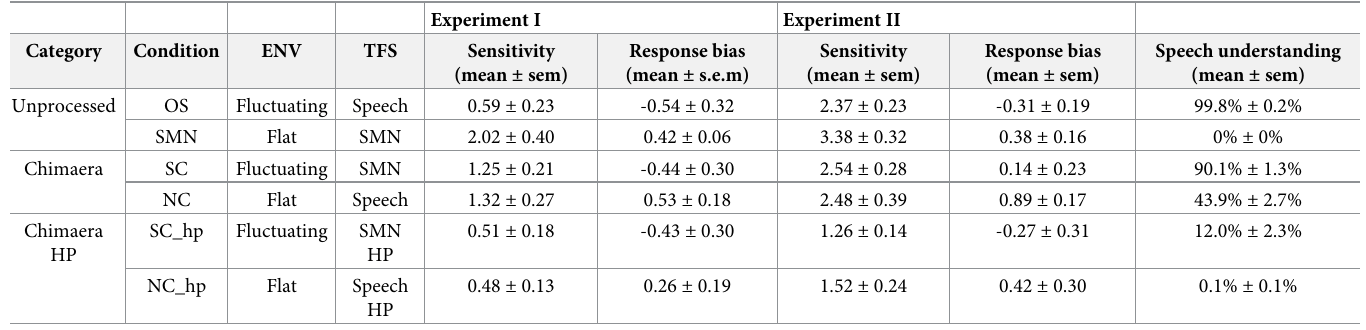
Table 1. Experimental conditions and data.